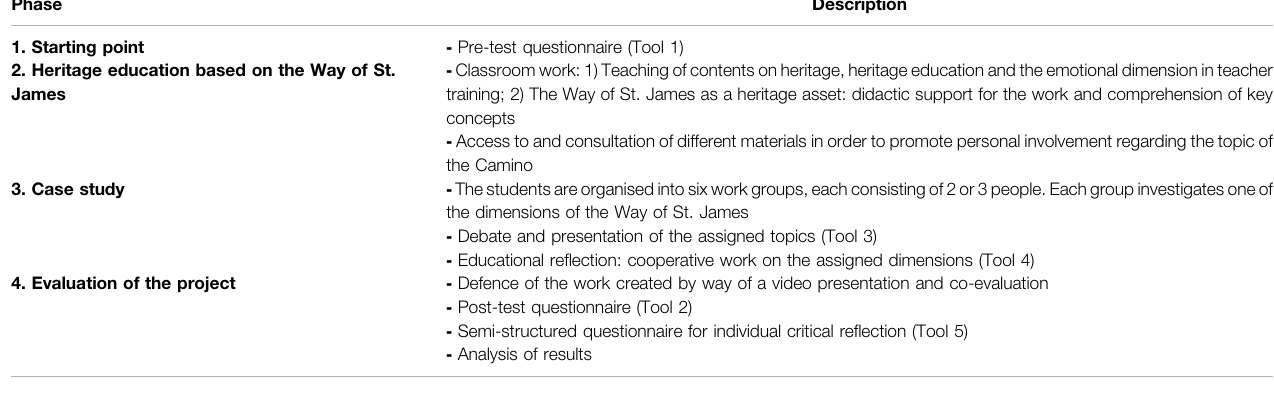
TABLE 2 | Procedure of the educational research carried out. Phase